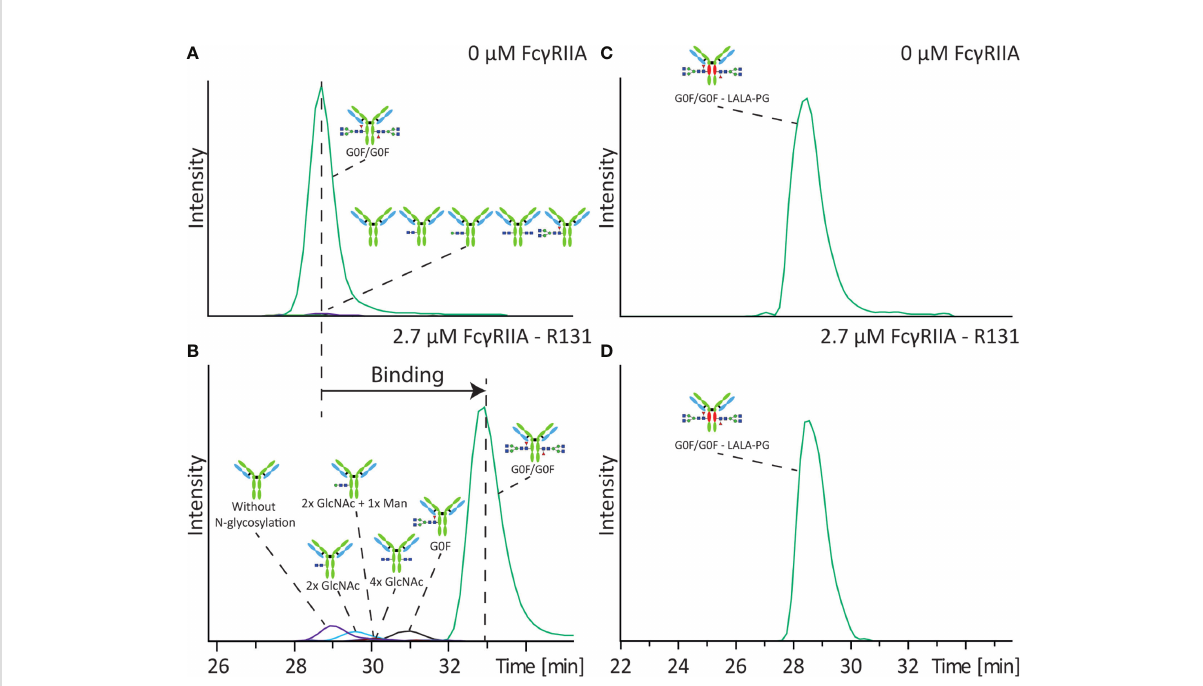
FIGURE 2 In fl uence of Fc N-glycan occupancy on binding towards Fc g RIIa. Af fi nity CE-MS analysis of mAb-A (A) without Fc g RIIa or (B) with 2.7 µM Fc g RIIa R131 variant in the background electrolyte. In different colors are the extracted ion electropherograms (EIEs) of the illustrated antibody molecules with different degree of glycosylation. Analysis of mAb-B containing a LALA-PG mutation with (C) 0 µM Fc g RIIa or (D) with 2.7 µM Fc g RIIa R131